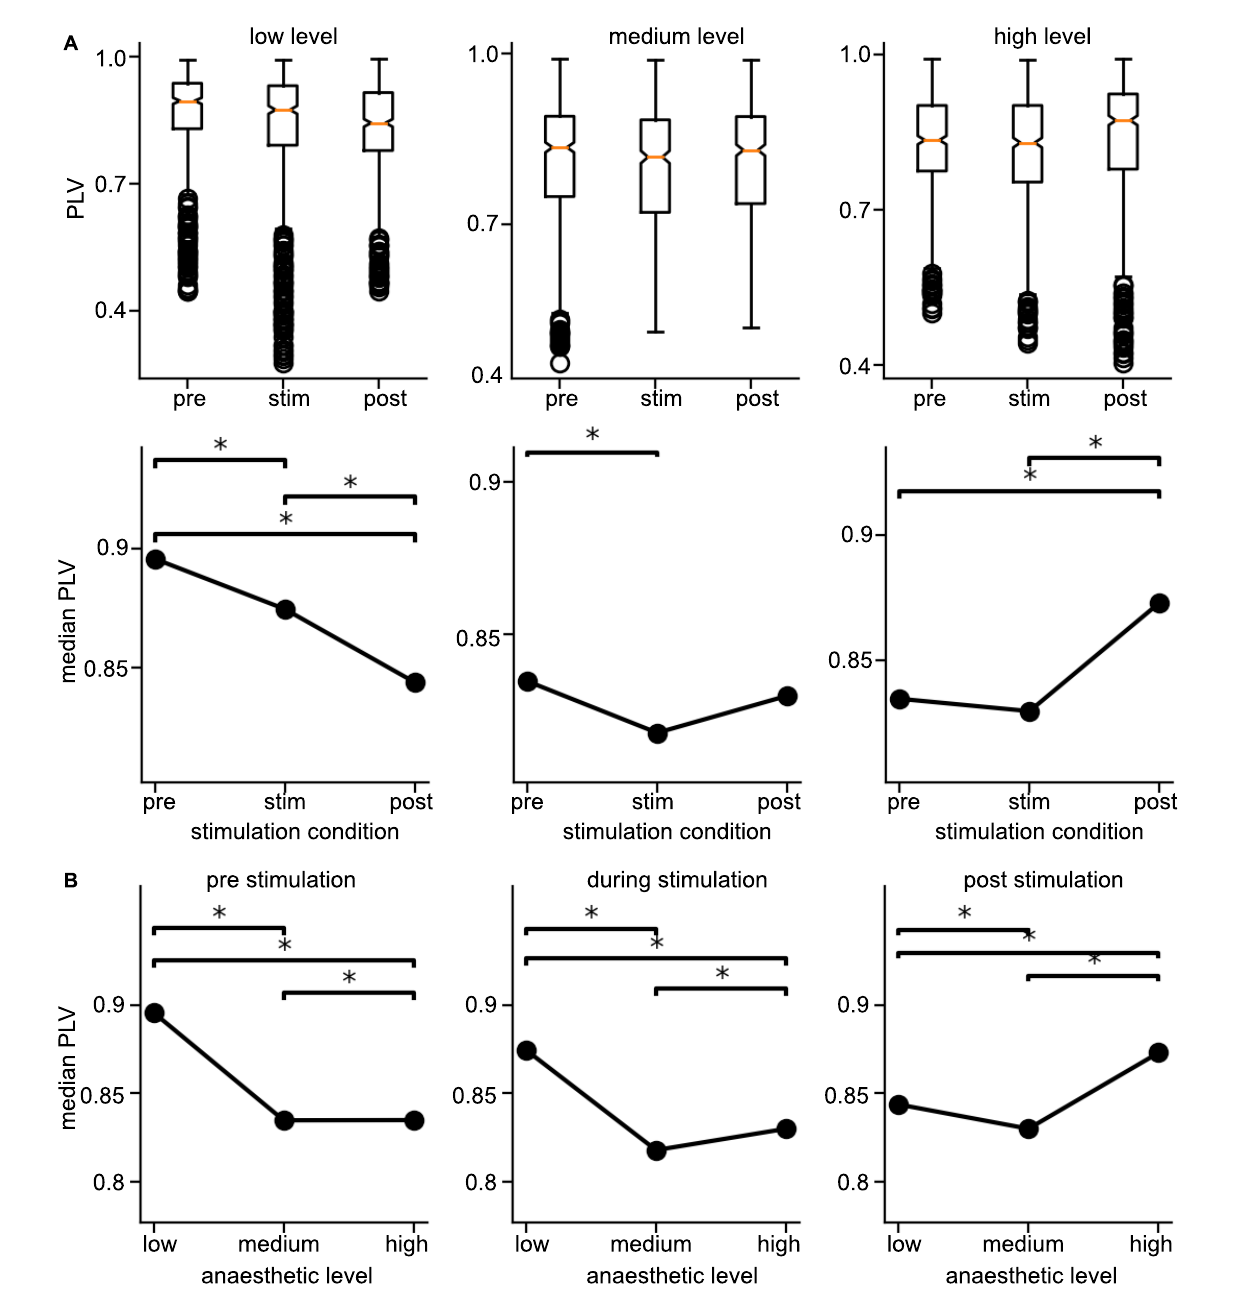
FIGURE6 Distribution of Phase Locking Values (PLVs) and of their significantly different median values in slow oscillations. (A) Box plots of PLVs (top panels) and their median values (bottom panels). *Statistically different median values between stimulation conditions are indicated by horizontal starred brackets. (B) Statistically different medians between anesthetic levels are indicated by horizontal starred brackets. PLV values were taken from channel clusters C2 and C3, significance level α = 0.05 with Mann–Whitney U-test based on data from all